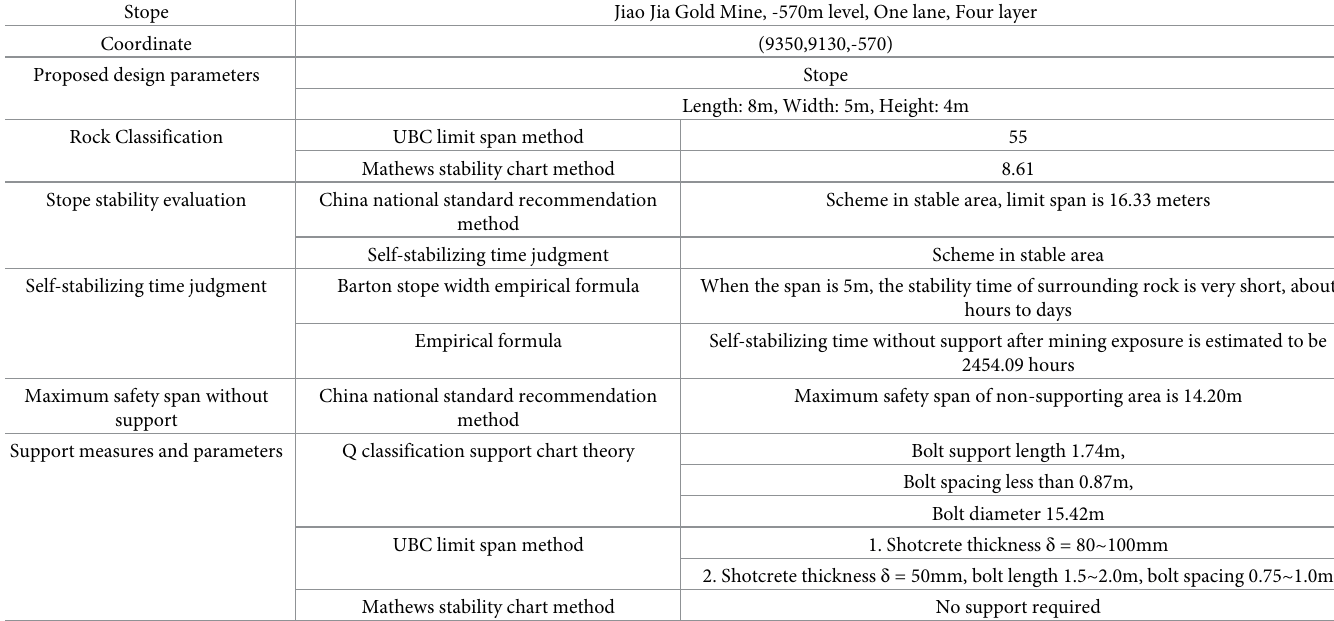
Table 7. Results of